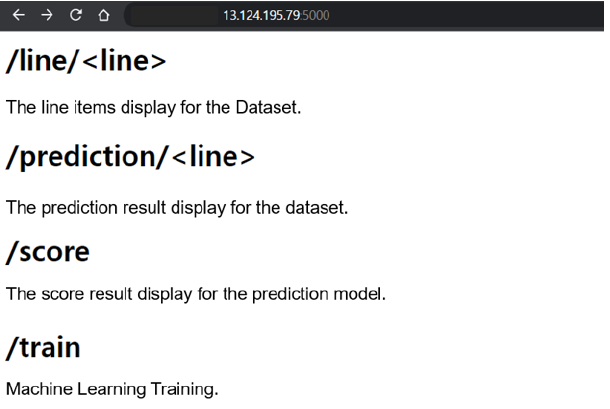
Figure 12. Documentation for REST-API.